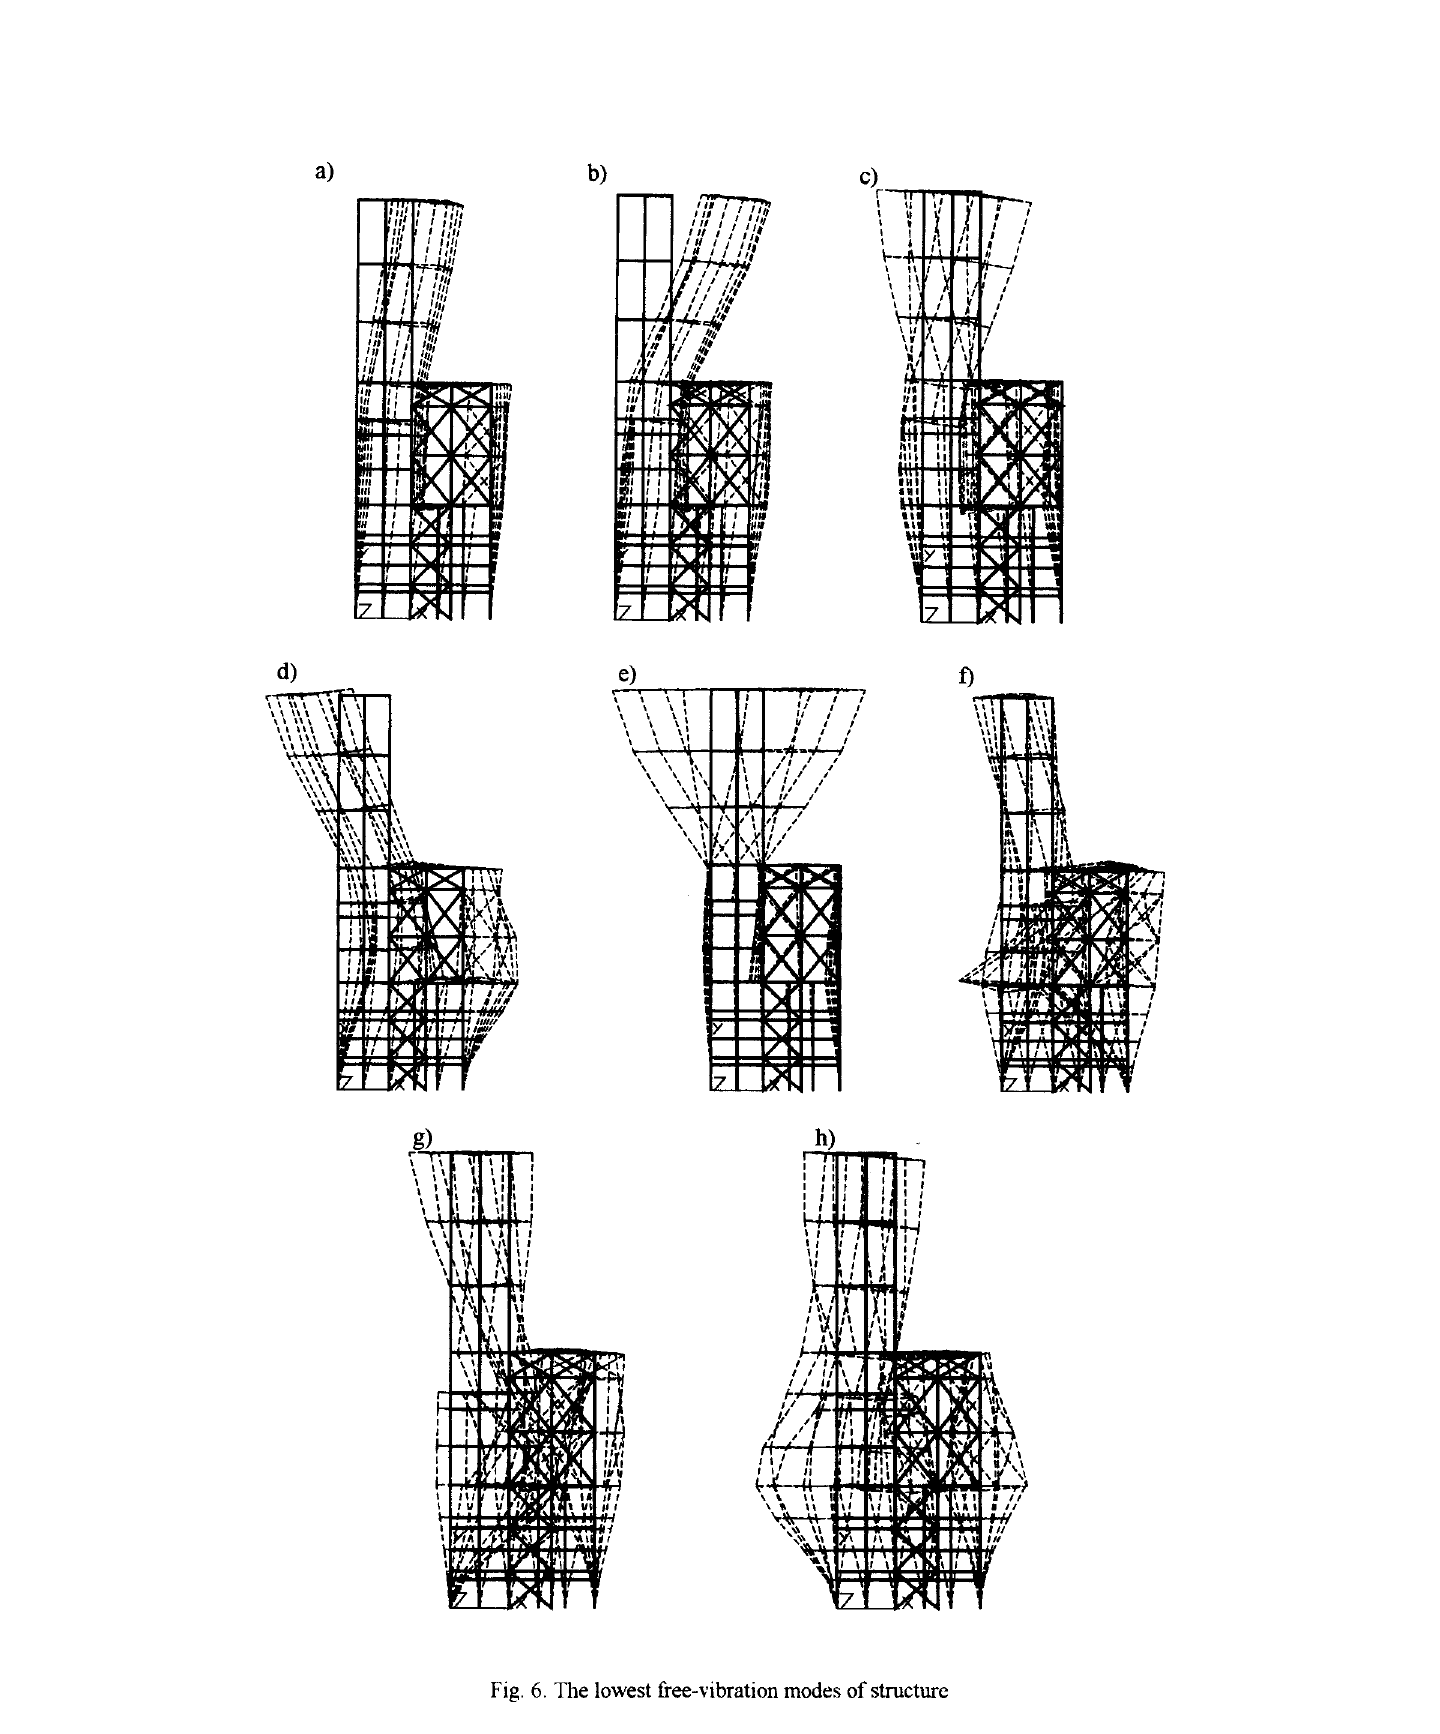
Fig. 6. The lowest free-vibration modes of structure